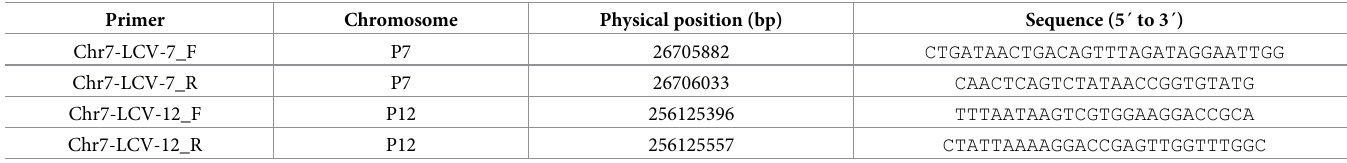
Table 5. Marker sequence information used for QTL validation and